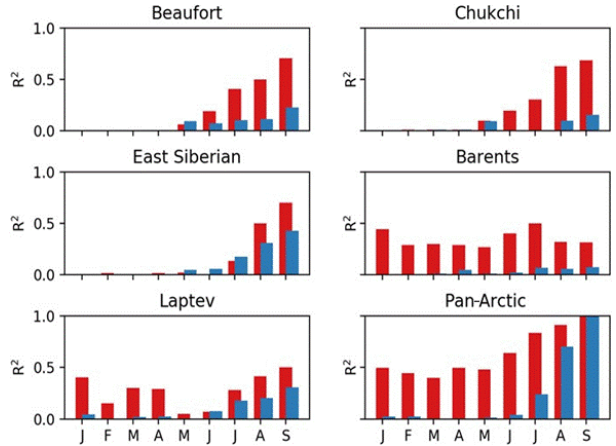
Figure 9. Examples of variances of September pan-Arctic ice ex- tent explained by correlations with antecedent regional ice extent in individual calendar months from September back to January (pan- Arctic extent lagging by 0, 1, 2, ..., 8 months). Plotted values are squares of correlations (i.e., explained variances). Red bars are val- ues with trends included, and blue bars are squared correlations af- ter removal of trends. The 95% significance thresholds for the R 2 values range from 0.07 with no autocorrelation (generally the case for detrended data) to 0.14 with an autocorrelation of 0.4.